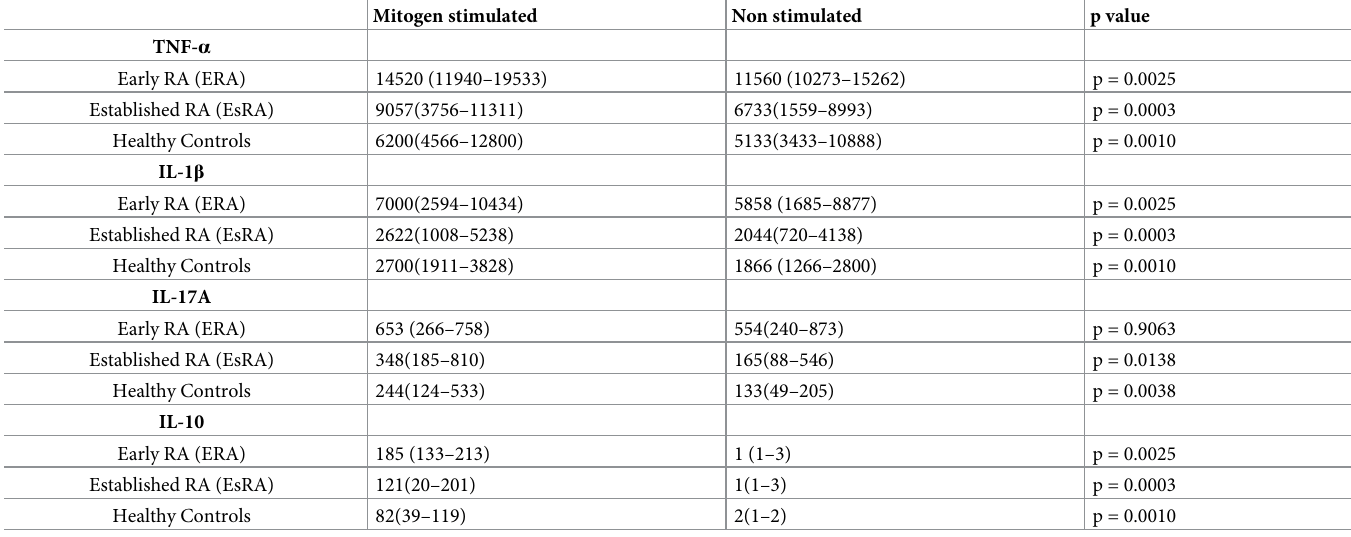
Table 2. Median and inter-quartile ranges of Spot Forming Cells (SFCs) per 10 5 PBMCs in the presence or absence of mitogen stimulation of PBMCs in RA patient groups and HCs. Mitogen stimulated Non stimulated p